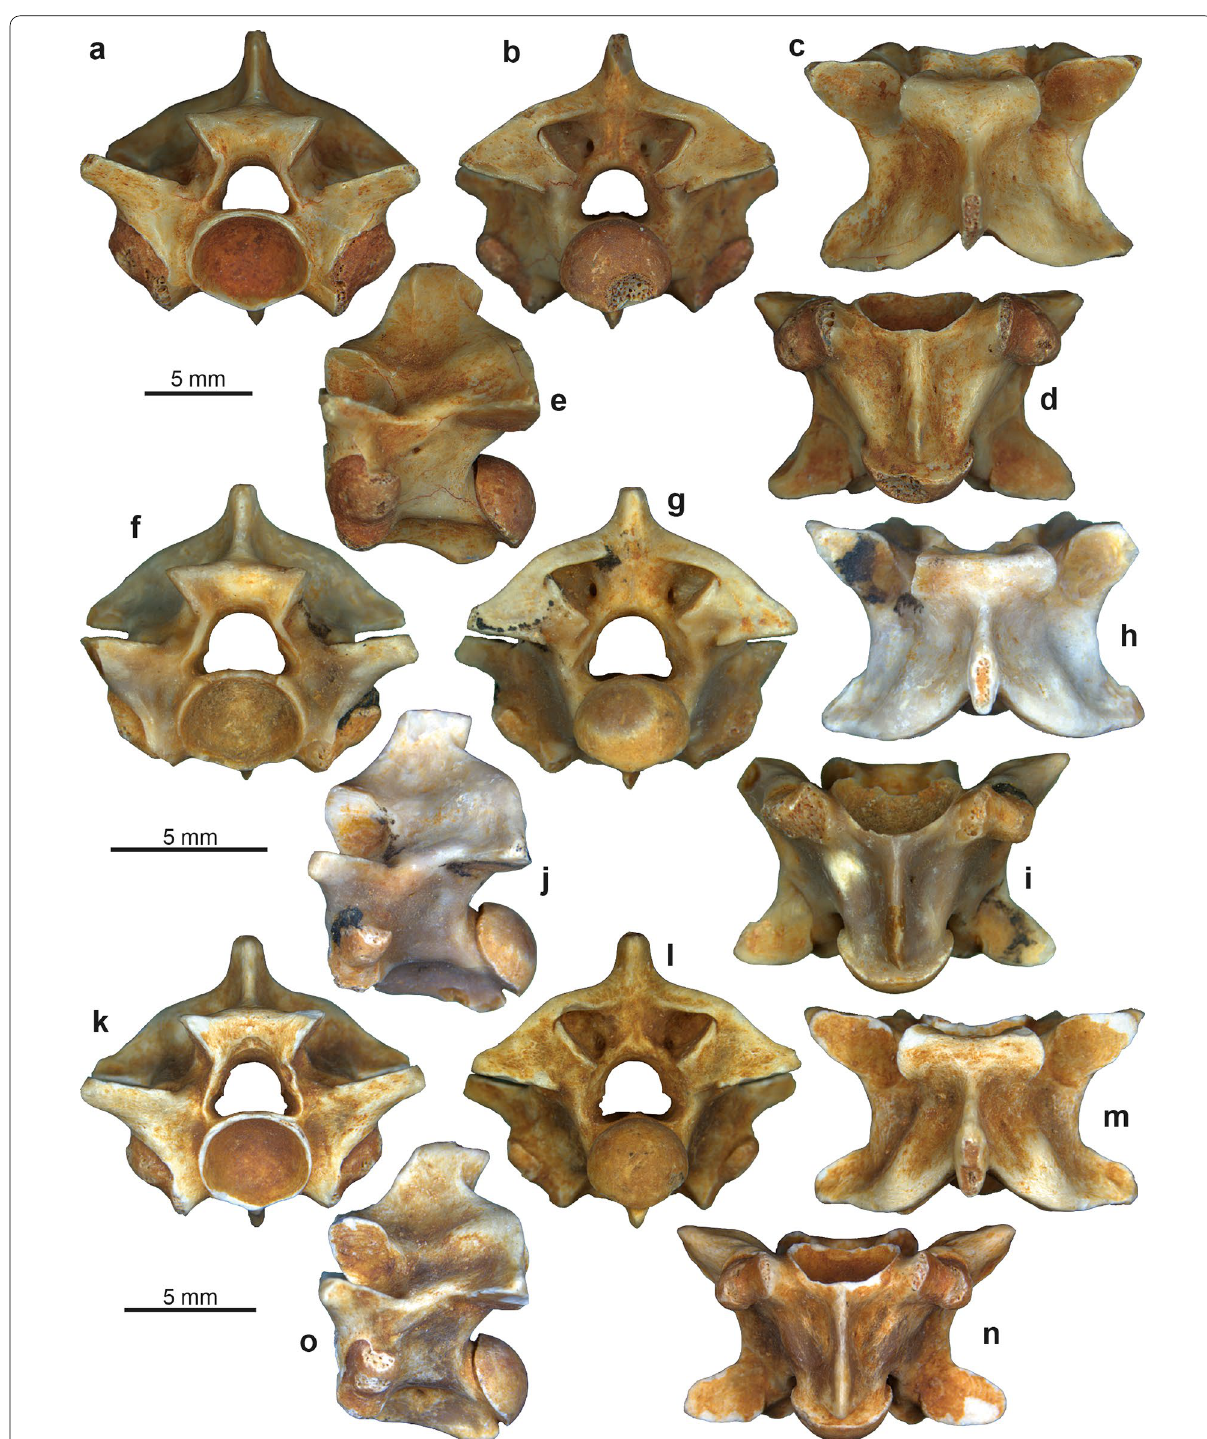
Fig. 84 Phosphoroboa filholii comb. nov. from imprecisely known locality(ies) near Mouillac, Phosphorites du Quercy: a – e mid-trunk vertebra (YPM-VPPU 30374) in anterior ( a ), posterior ( b ), dorsal ( c ), ventral ( d ), and left lateral ( e ) views; f – j mid-trunk vertebra (YPM-VPPU 30381) in anterior ( f ), posterior ( g ), dorsal ( h ), ventral ( i ), and left lateral ( j ) views; k – o mid-trunk vertebra (YPM-VPPU 30383) in anterior ( k ), posterior ( l ), dorsal ( m ), ventral ( n ), and left lateral ( o )